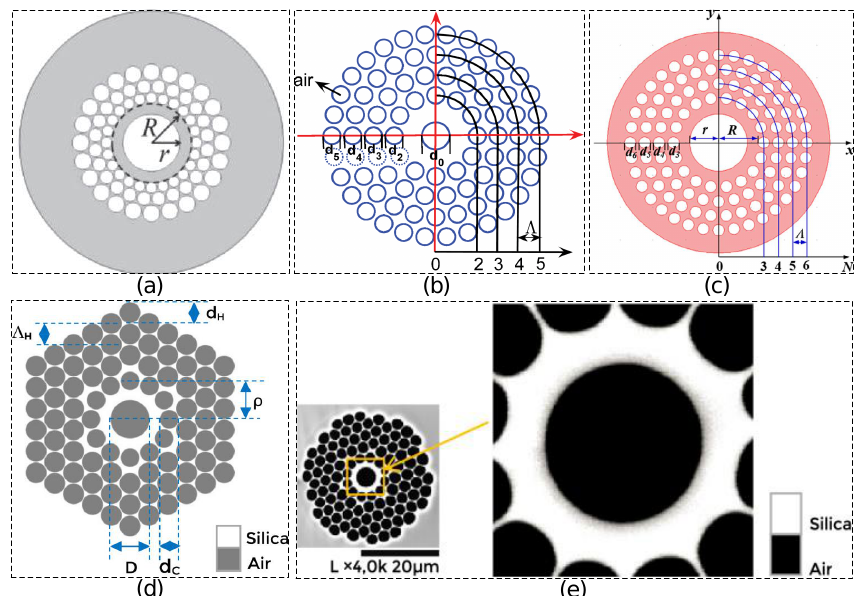
Figure 9. The cross sections of PCFs supporting OAM modes. ( a ) Heterogeneous air-hole cladding design. Adapted with permission from Ref. [64] © IEEE. RC-PCFs with cladding constructed by identical air-holes supporting ( b ) 14 and ( c ) 26 OAM modes. Adapted with permission from Ref. [37] © IEEE and Ref. [65] © Elsevier. ( d ) A design of RC-PCF with cladding that consists of a circular layer of air-holes and three hexagonal layers of air-holes. ( e ) The fabricated RC-PCF based on the design in ( d ). Adapted with permission from Ref. [66] © The Optical